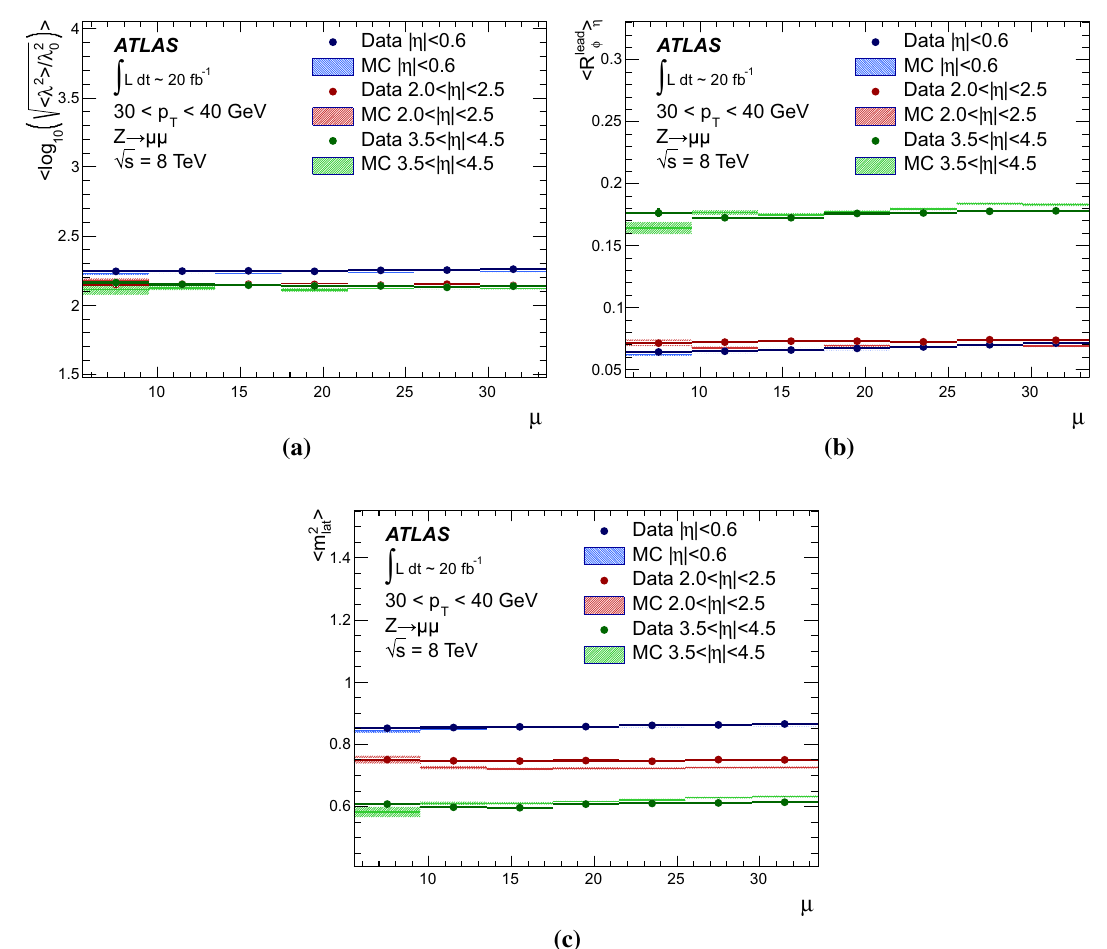
Fig. 44 The average pile-up dependence of various geometric observ- ables reconstructed from the leading topo-cluster in anti- k t jets recon- structed with R = 0 . 4 and 30GeV < p LCW + JES Z → μμ events in 2012 data and MC simulations with fully simulated pile-up. The average cluster length, represented by log 10 ( (cid:7) λ 2 /λ 2 with the reference scale λ 0 = 1mm, is shown as a function of μ in a , for three detector regions. The average size (cid:7) R lead ηφ (cid:8) of the lead-